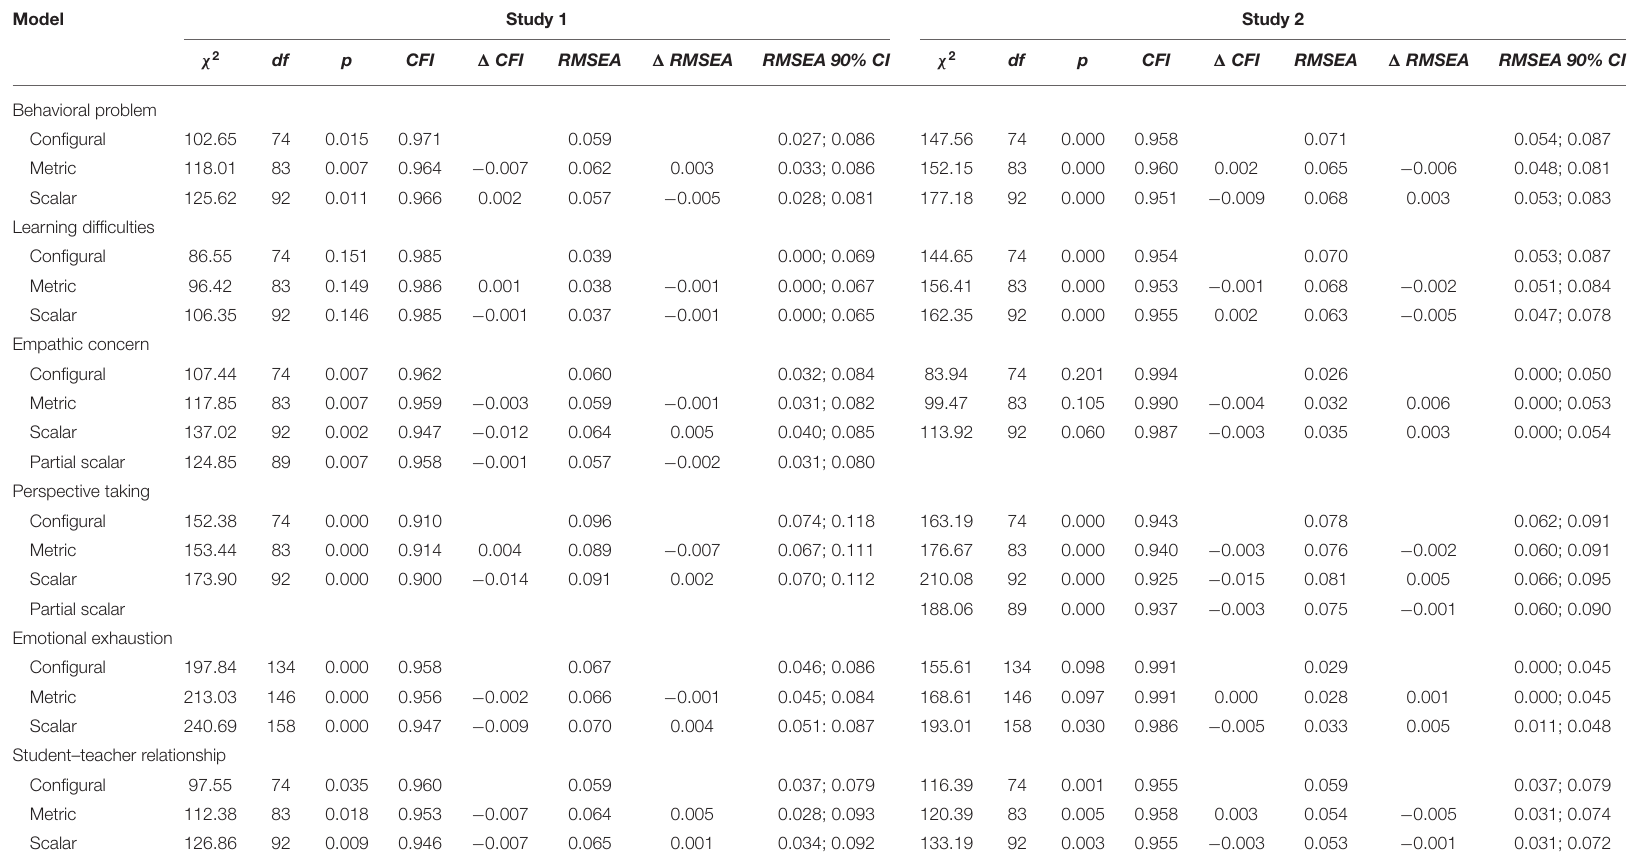
TABLE 2 | Model fit statistics for testing of measurement